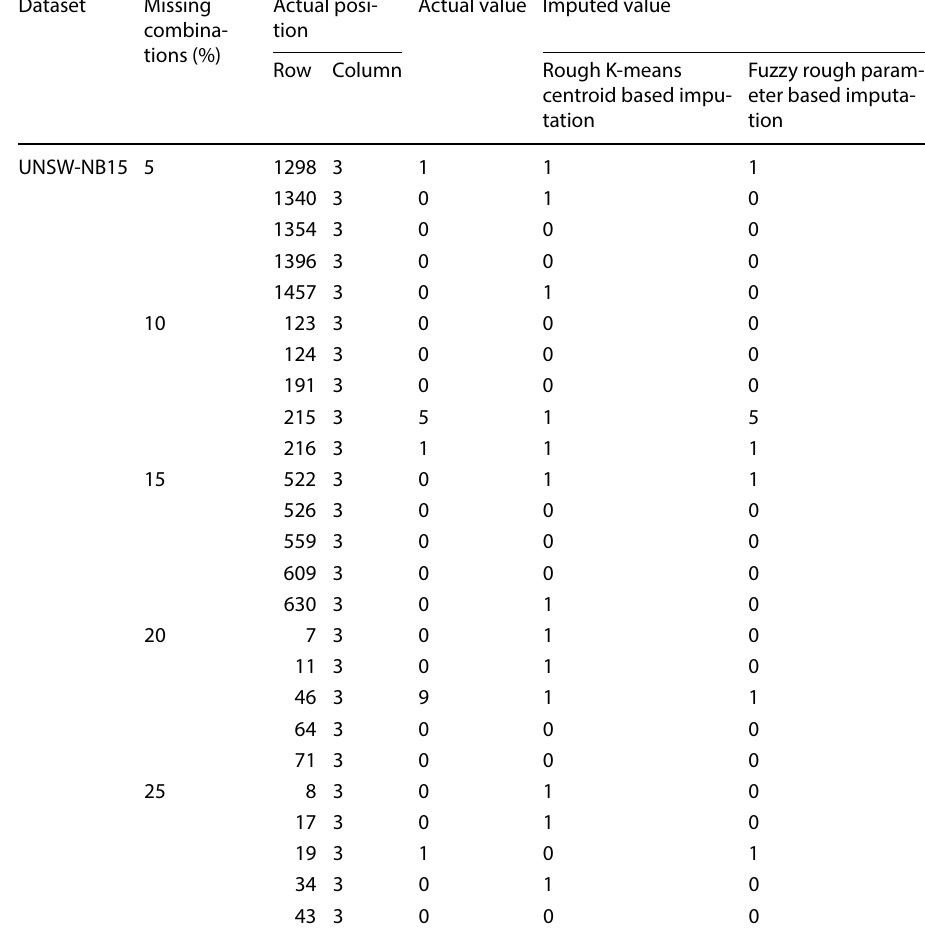
Table 2 Quantitative performance on UNSW-NB15 dataset